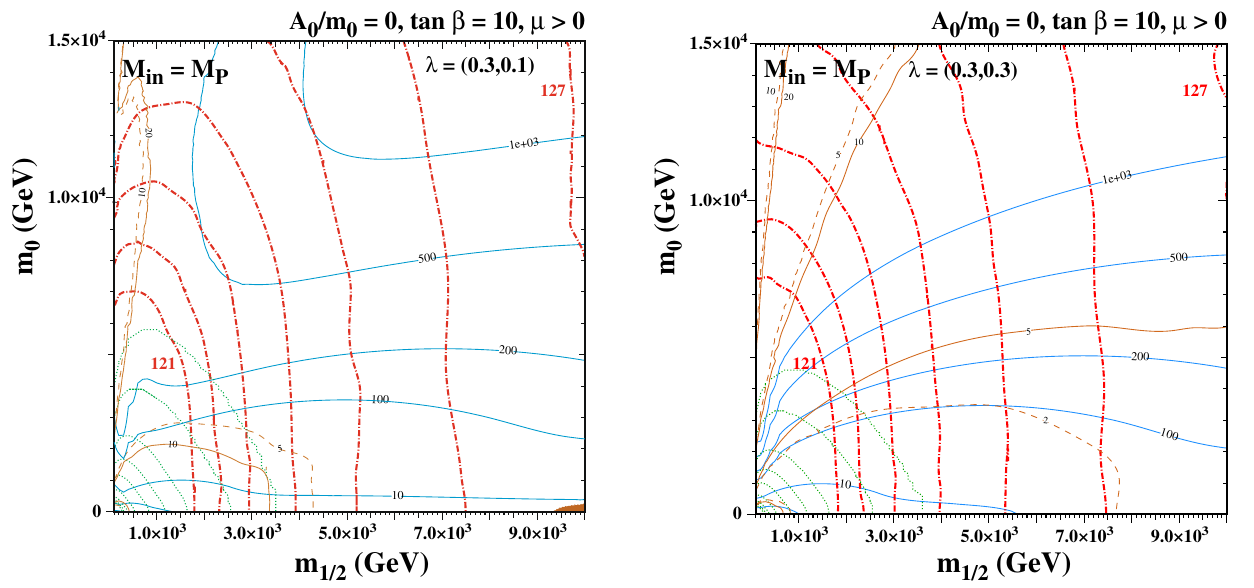
Fig. 5 Representative ( m 1 / 2 , m 0 ) planes in the FSU(5) GUT model. The fixed parameters as the same as in Fig. 1, except for M in = M P and λ = (0.3,0.1) in the left panel and λ = (0.3,0.3) (right). The contours are as in Fig. 1